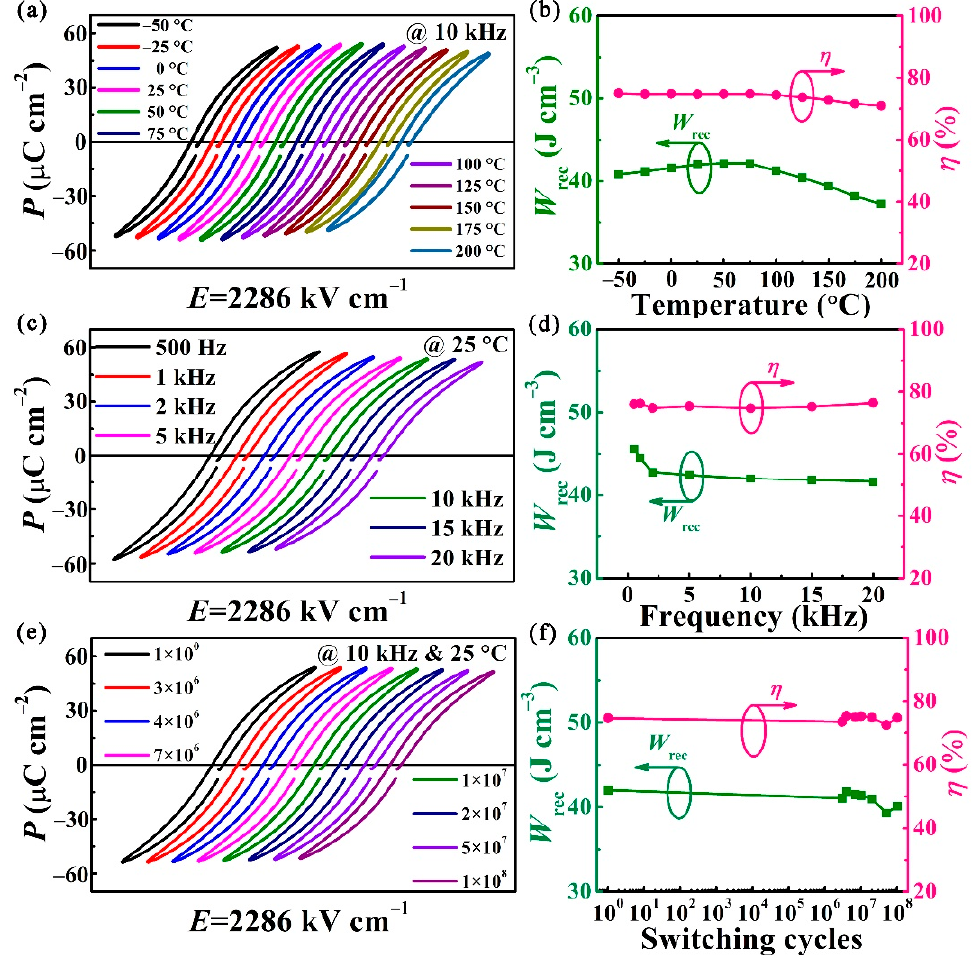
Figure 3. ( a ) The P-E curves and ( b ) the corresponding W rec and η measured from − 50 to 200 ◦ C at 2286 kV cm − 1 . ( c ) The P-E curves and ( d ) the corresponding W rec and η with various frequencies measured under 2286 kV cm − 1 . ( e ) The P-E curves and ( f ) the corresponding W rec and η during the 10 8 fatigue cycles at 2286 kV cm − 1 . The measurements are realized at about 76% of E b .